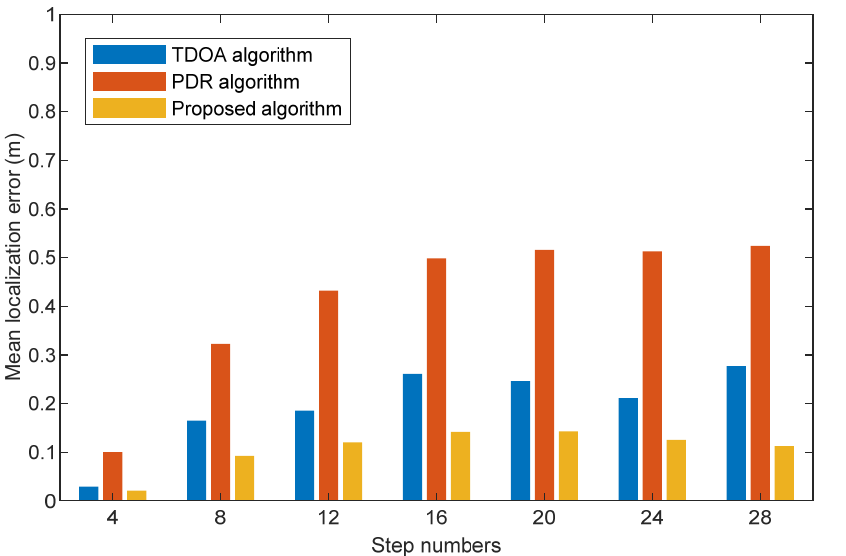
Figure 15. Mean localization error comparison with TDOA algorithm, PDR algorithm, and the proposed algorithm at different step numbers (Third scene).